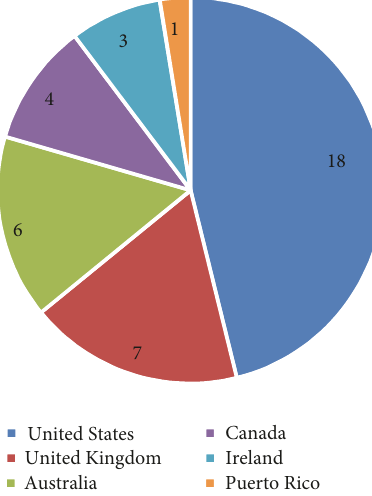
Figure 2: Study country of origin. 𝑁𝑜𝑡𝑒 . Two articles were based on research conducted in two countries equaling 39